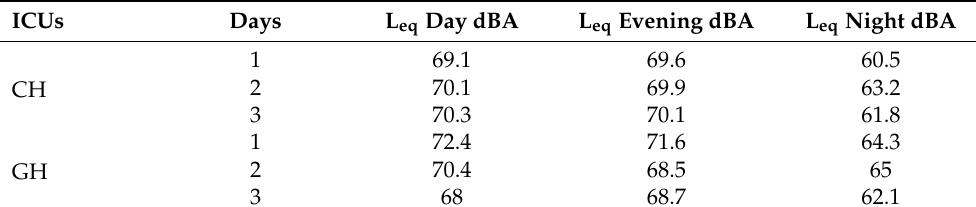
Figure 5. shows the weekly noise level in the GH. Note: The middle line represents 35 dBA, the WHO-recommended noise level during the day, while the lowest line (dash line) represents 30 dBA, the WHO recommendation during the night. The noise produced by this equipment greatly surpasses the acceptable noise levels in the ICU. Table 6. Noise equivalence levels for the day, evening, and night times on each day.